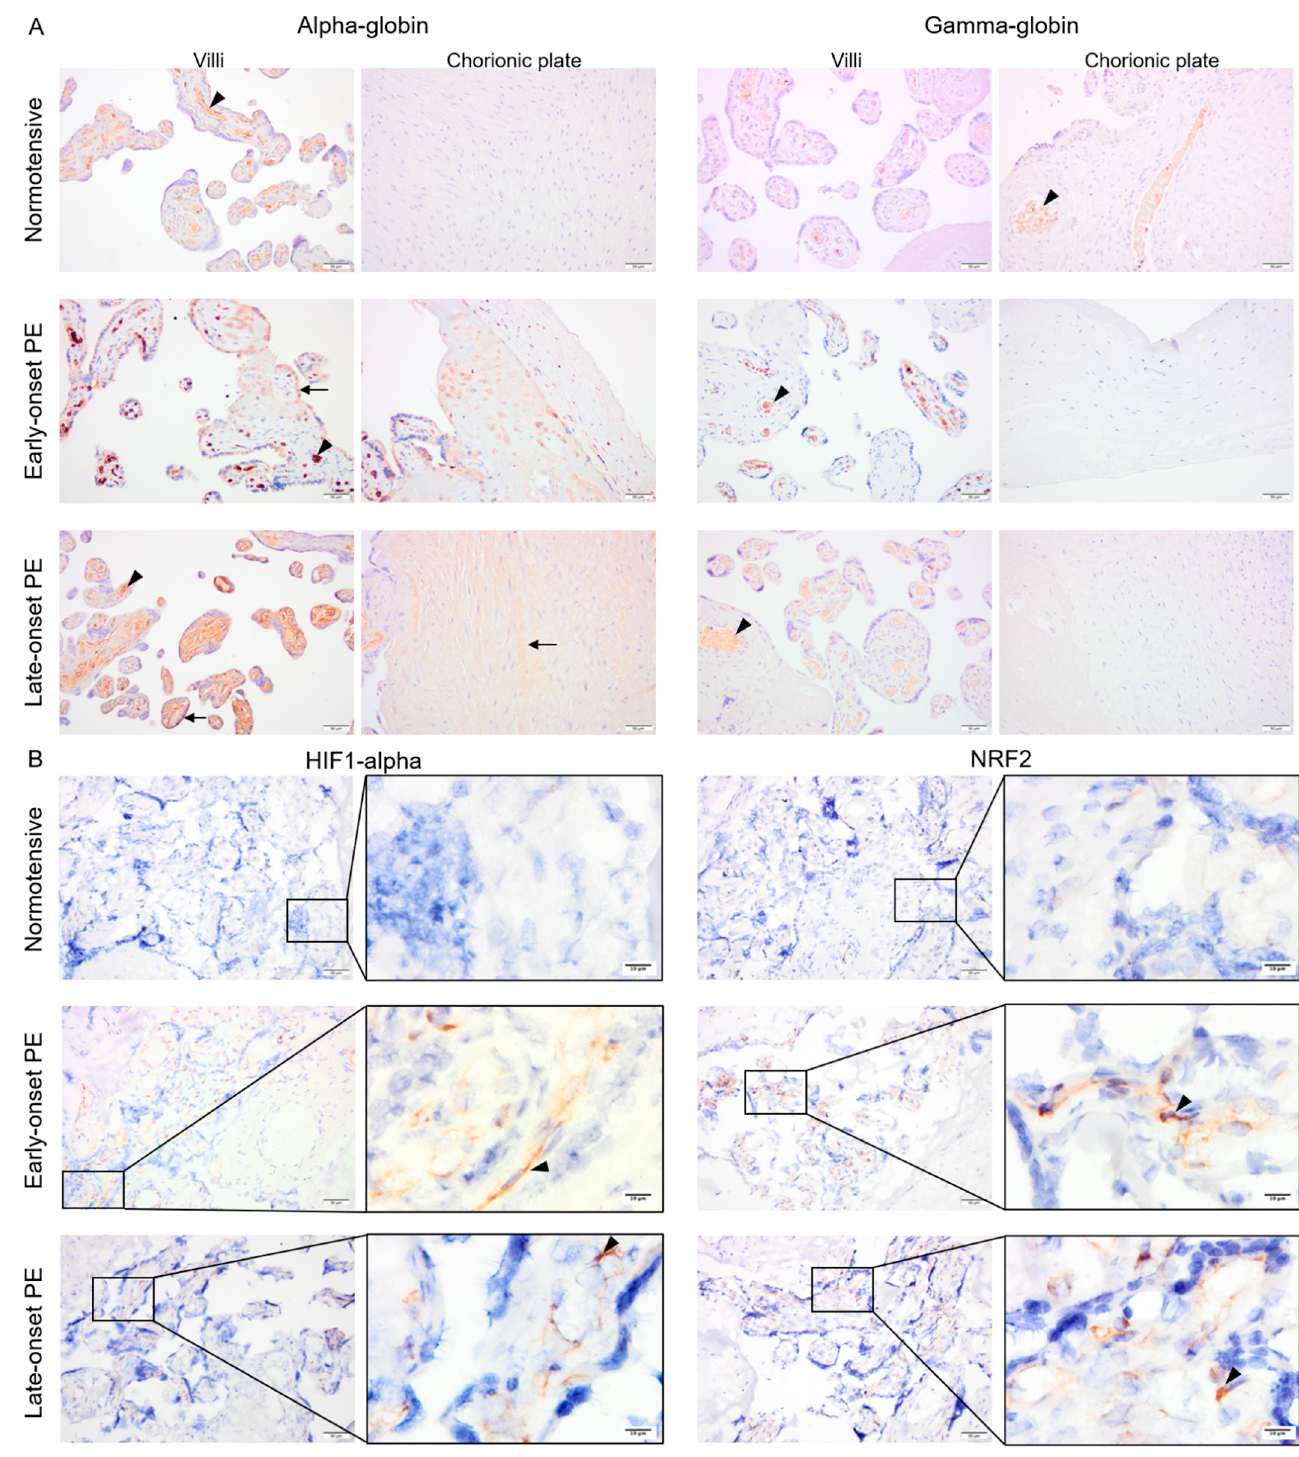
Figure 3. The pattern of alpha- and gamma-globin as well as HIF1-alpha and NRF2 proteins in placentas from normotensive, early-, and late-onset PE pregnancies. Alpha- and gamma-globin proteins were detected in erythrocytes in all three groups (arrowhead) ( A ). In early-onset PE, alpha globin protein was also clearly detected in trophoblasts and sparsely in the villous stroma (arrow) ( A ). In late-onset PE, alpha-globin was found in stroma of the villi and the chorionic plate (arrow) ( A ). Both HIF1-alpha and NRF2 protein expression were strongly detected in villous stroma of placentas from early- and late-onset PE pregnancies (arrowhead), but only minimal in normotensive placentas ( B ). Scale bar is 50 µm in all images except for inserted higher magnifications in B where it is 10 µm. Negative control is presented in Figure S1.